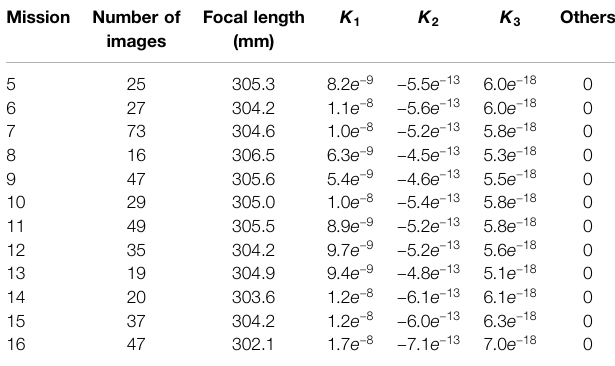
95% error intervals systematically below 40 m ( Supplementary